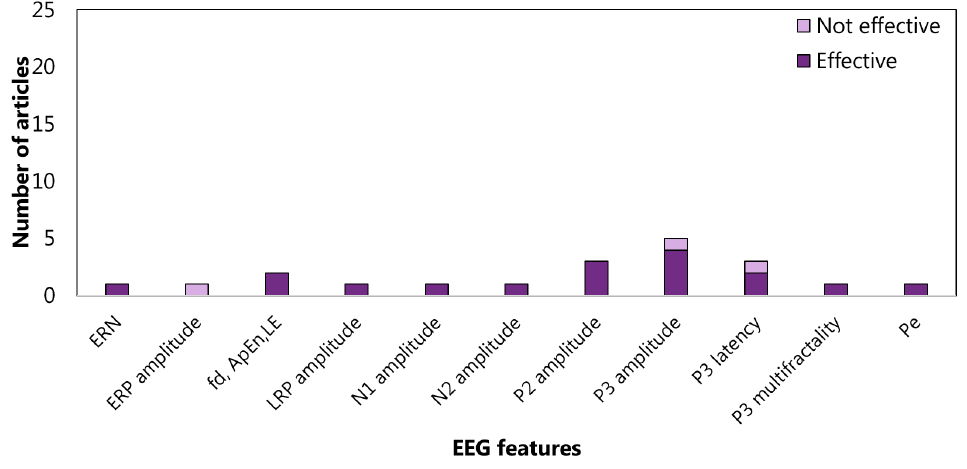
Figure 8. Articles focusing on the relationship between EFs from cluster working memory and EEG features from time domain. P300 amplitude is the feature most studied: four articles verified (effective) the relationship, and 1 article did not (was not effective). fd: fractal dimension; ApEn: Approximate Entropy; LRP: lateralised readiness potential; LE: Lyapunov Exponent ; ERN: error-related negativity; and Pe: error